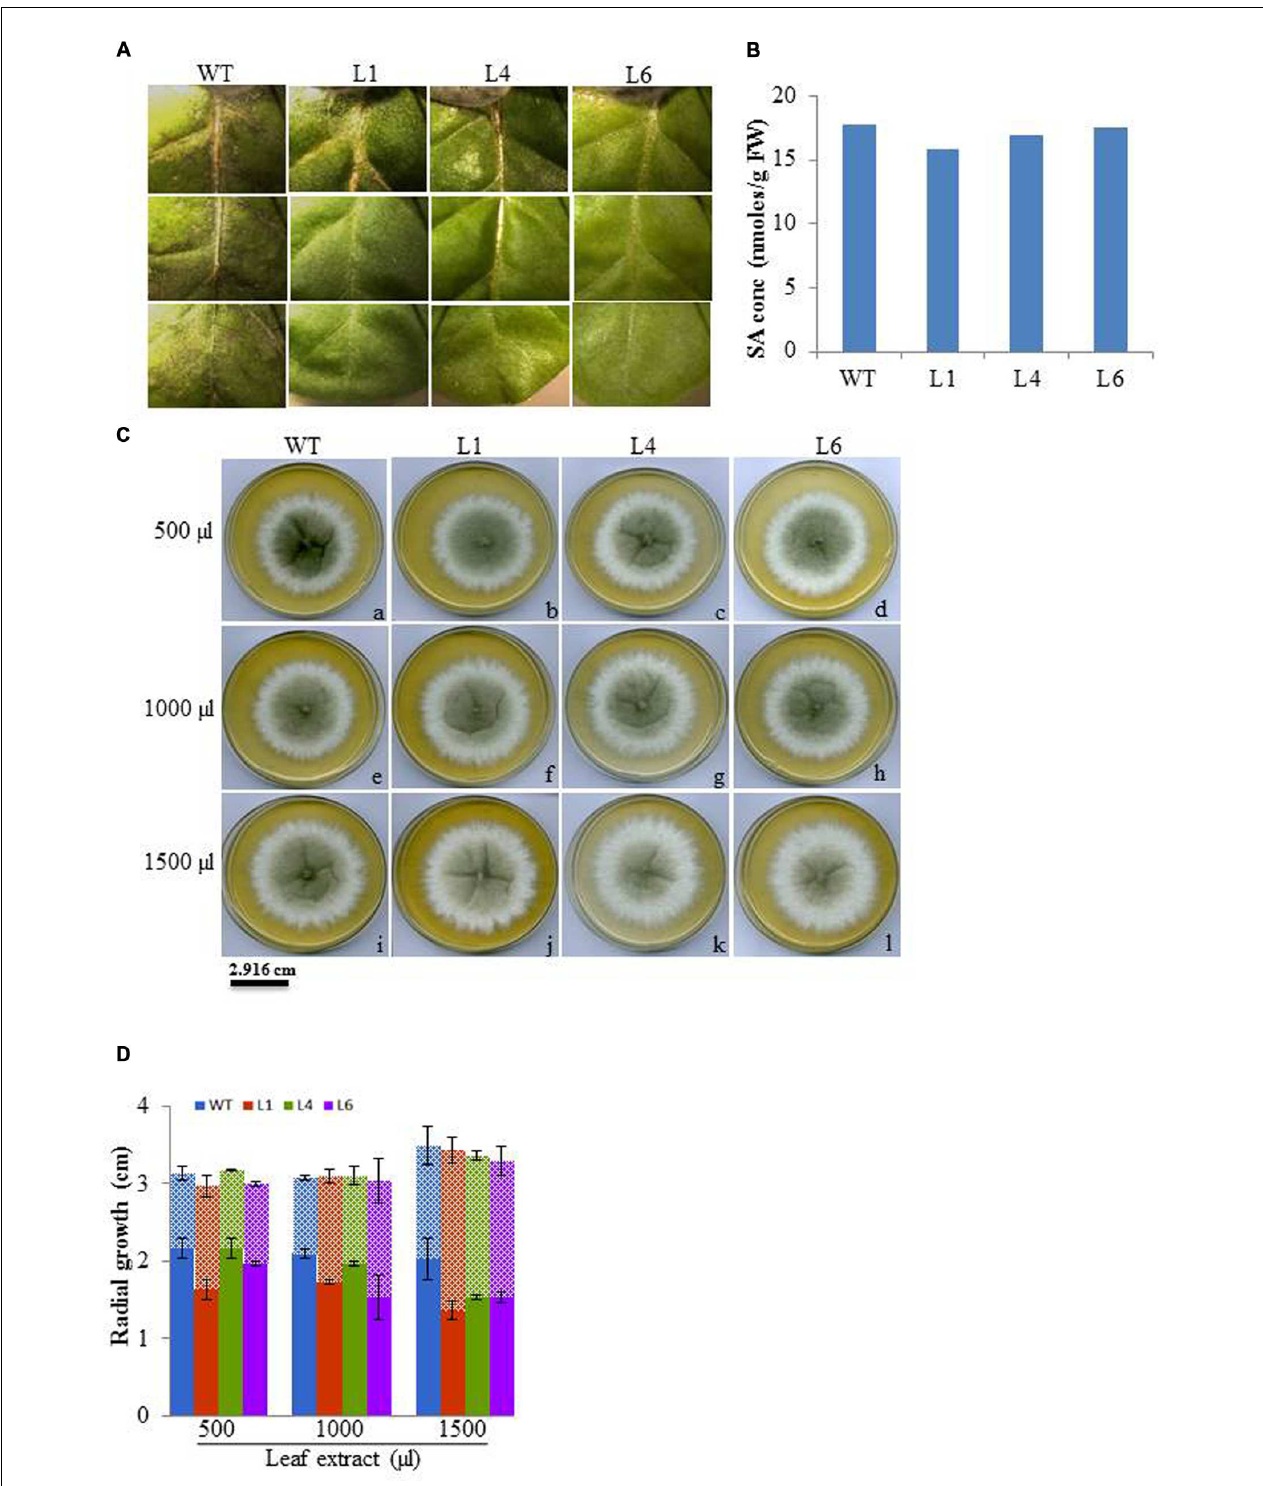
FIGURE 12 | (A) Severity of infection on WT and JcPR-10a transgenics (L1, L4, and L6) leaf incubated with Macrophomina phaseolina . (B) Salicylic acid content of healthy WT and transgenic (L1, L4, and L6) leaves. (C) Differential growth of Macrophomina fungus in potato dextrose medium supplemented with different amount (500, 1000, and 5000 µ l) of leaf extract from WT and transgenic lines (L1, L4, and L6). The black and white zone represents the reproductive and vegetative growth, respectively. (D) Graph representing the reproductive (microspores, in bold column) and vegetative (hypha, in pattern) growth. Data represent the mean ± SE of three biological